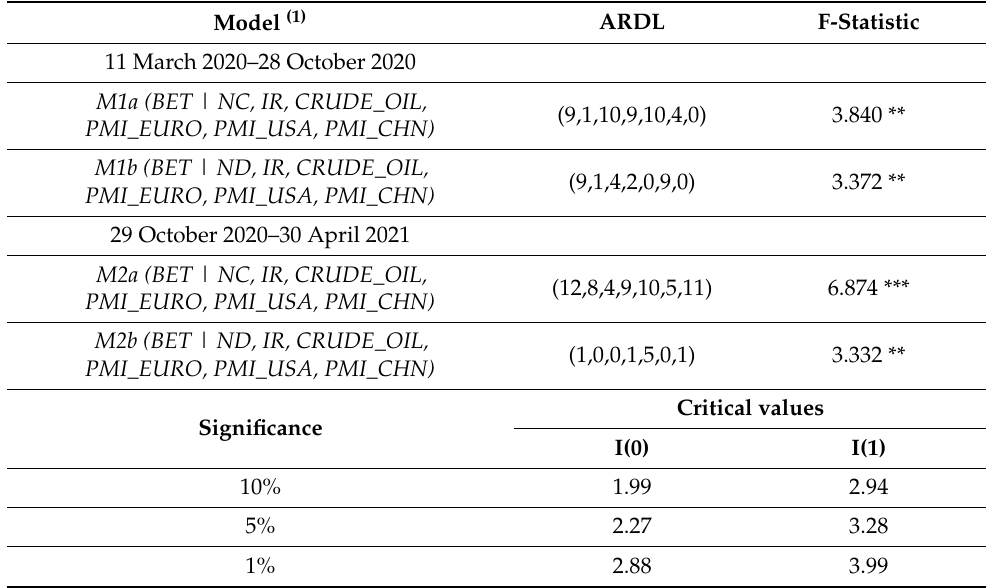
Table 5. Estimated ARDL models and Bounds F-test for cointegration. Model (1) ARDL